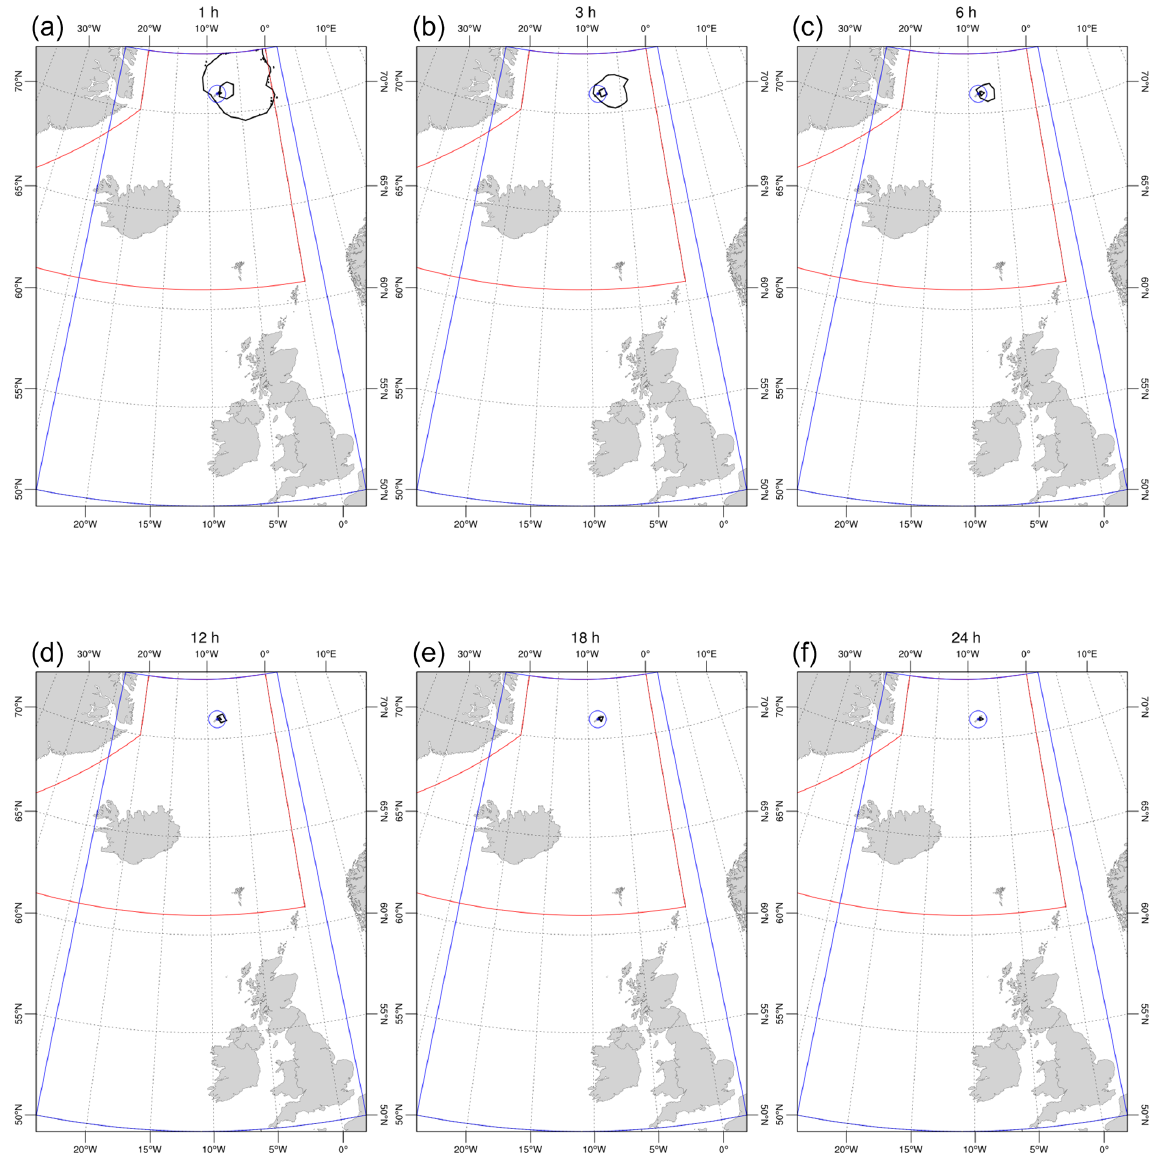
Figure D3. Persistence maps at FL250 (medium class): the isolines show the probability of reaching or exceeding an ash concentration above 2mgm − 3 at FL250 at 1, 3, 6, 12, 18, and 24h during the eruption to up to 48h after its end.